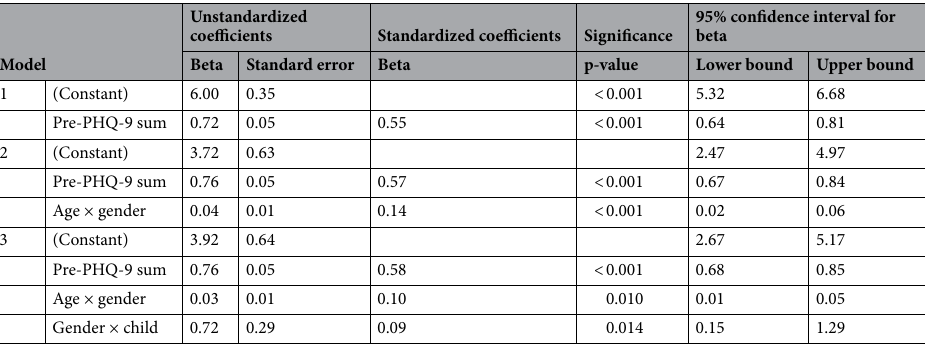
Table 5. PHQ-9 regression